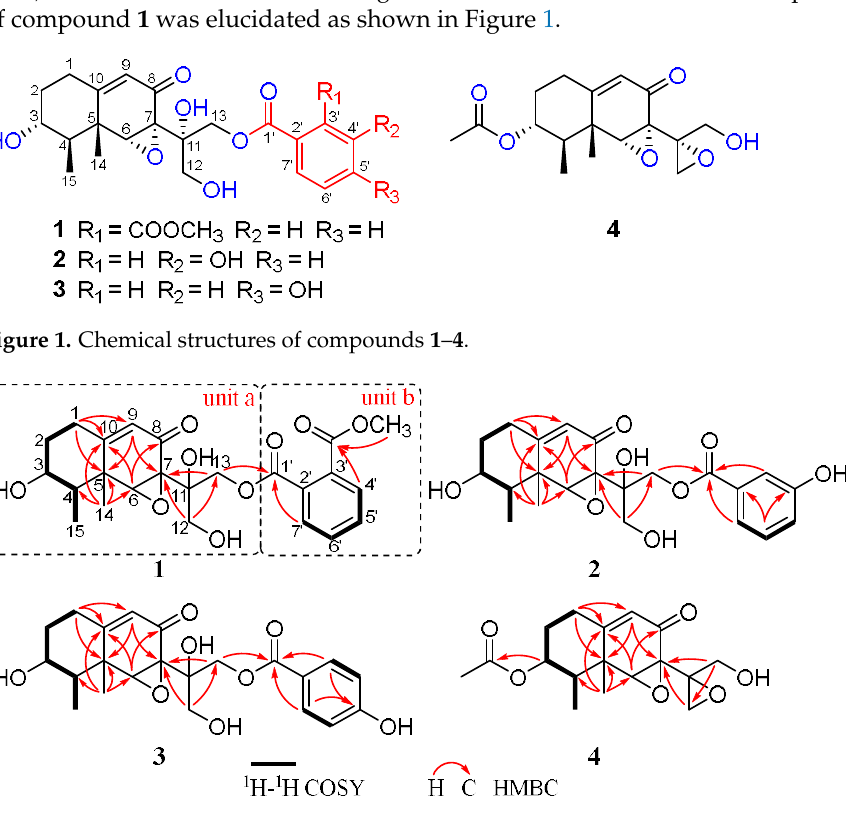
Figure 3. Key ROESY correlations of compounds 1 and 4 .